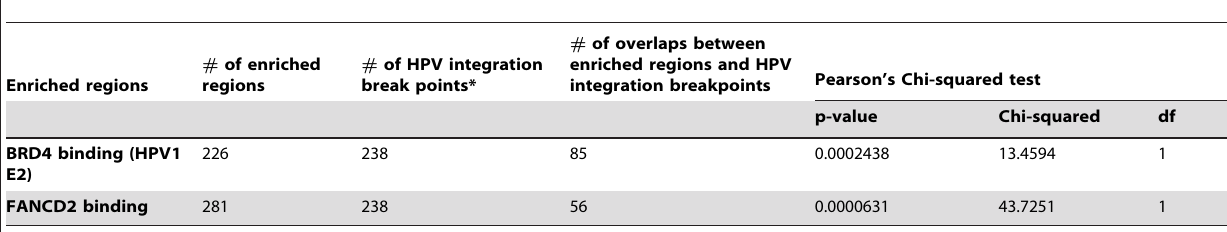
Table 2. Association of HPV integration sites with PEB-BLOCs and FANCD2 binding.